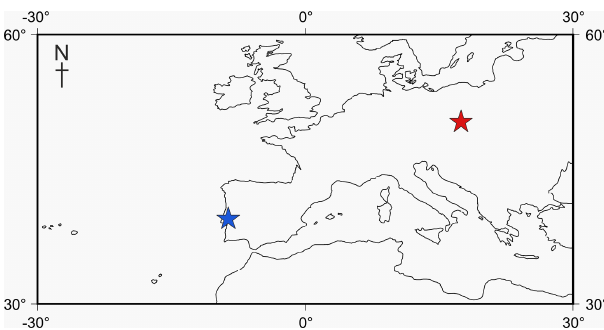
Figure 1. Locality map of Jurassic specimens. The Tojeira Forma- tion is indicated in blue, and Gnaszyn quarry in red. Further locality information provided in Gradstein et al. (2017a). Map taken from http://www.odsn.de, last access: 20 July